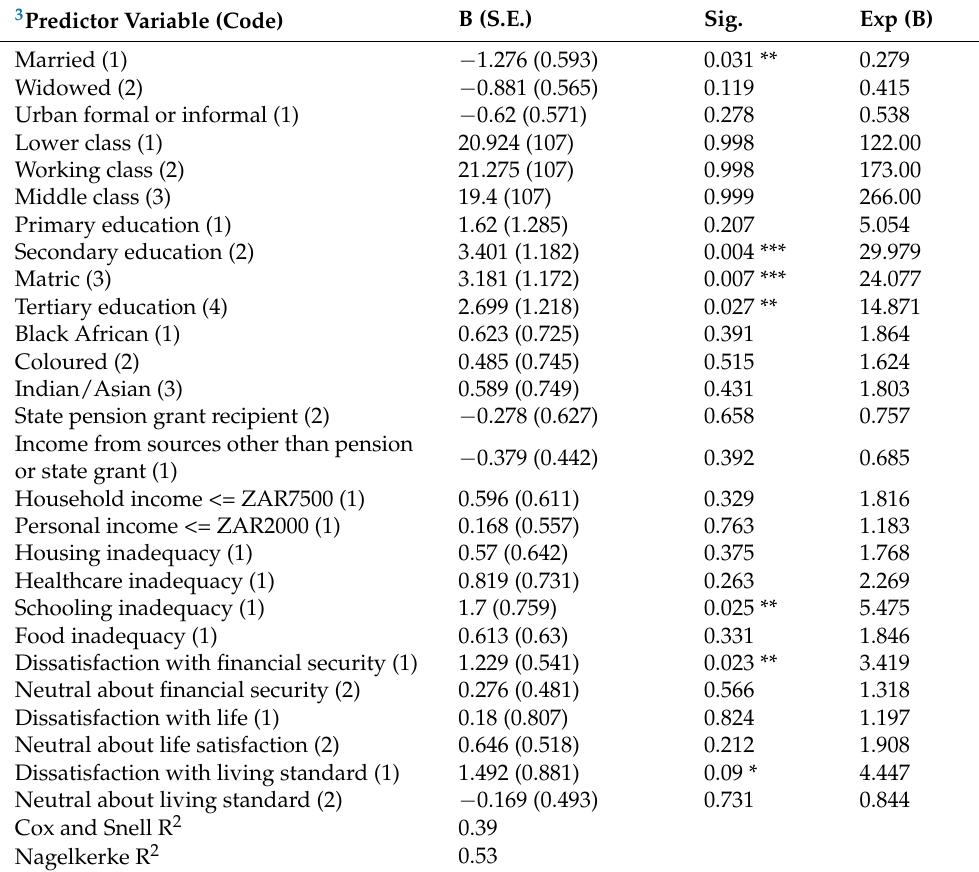
Table 4. A complete binomial regression analysis on Perceived poverty (Model